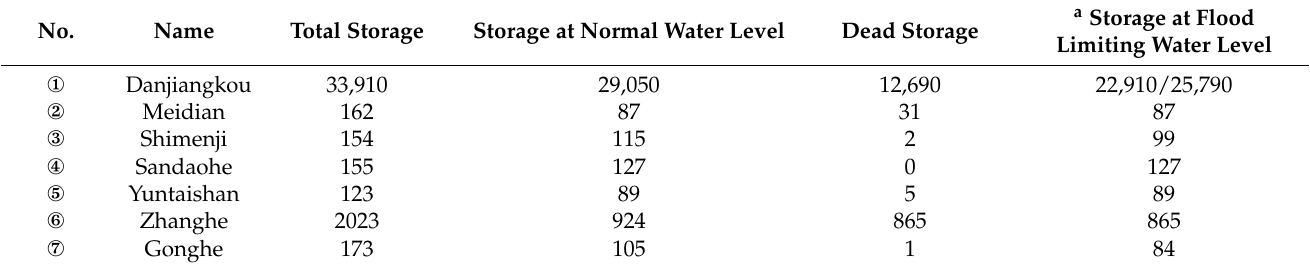
Table 2. Characteristics of the middle or large size reservoirs (million m 3